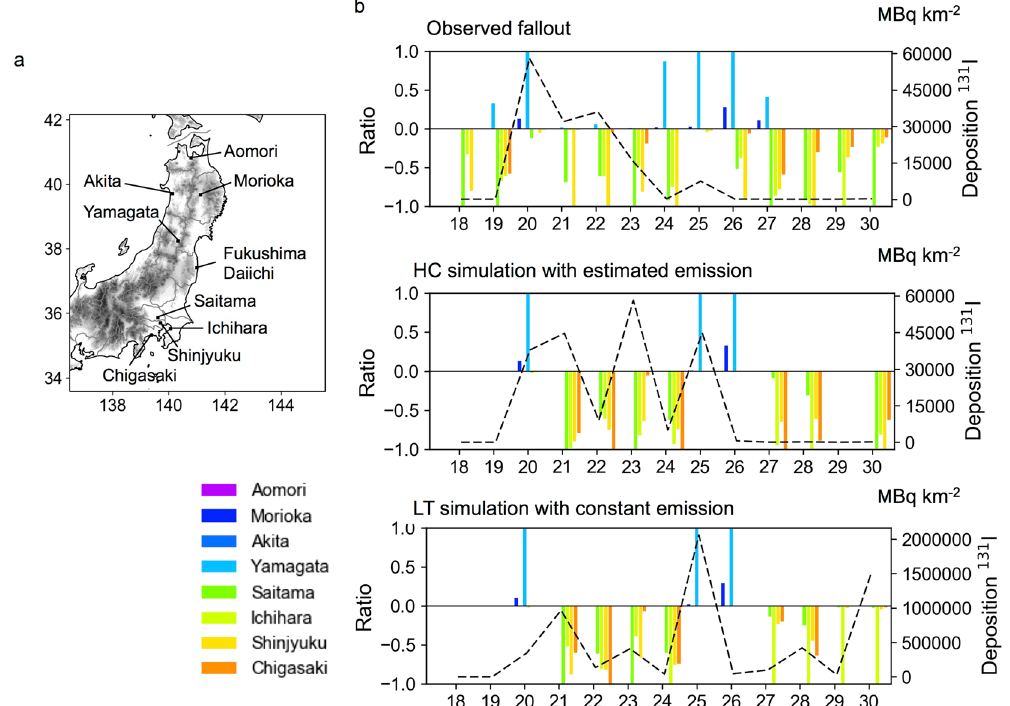
Figure 1. Meridional directions of disposition of 131 I ( a ). The sites where the daily cumulative deposition of radioactive materials was observed (Nuclear Regulation Authority, Japan). ( b ) Temporal variations of the observed and simulated deposition amounts in March 2011. The bars indicate the ratio of the deposition at each point to the maximum among the eight points and the dashed lines are the maximum daily deposition among the eight points. Four of the points are located to the north of the FDNPP (positive values), whereas the others are located to the south of the FDNPP (negative values). The map and graphs were created using Python